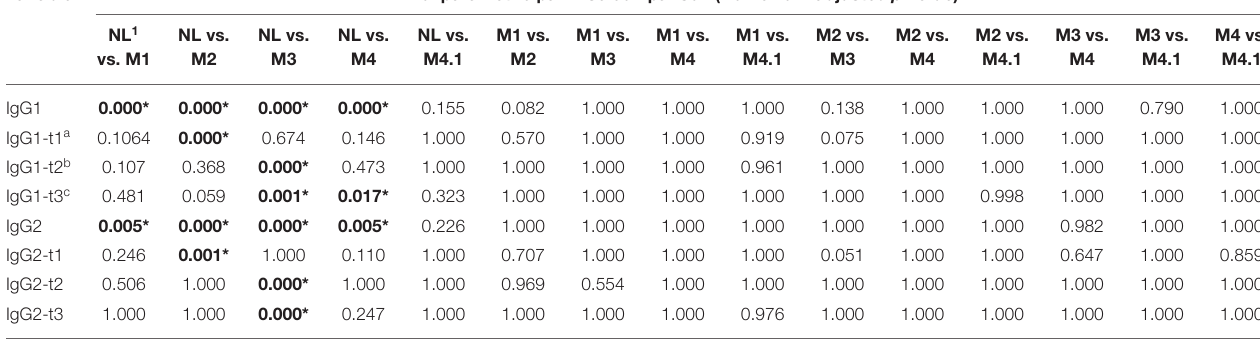
TABLE 7 | Pairwise comparison of mean absorbance readings across different BDD lesion scores.